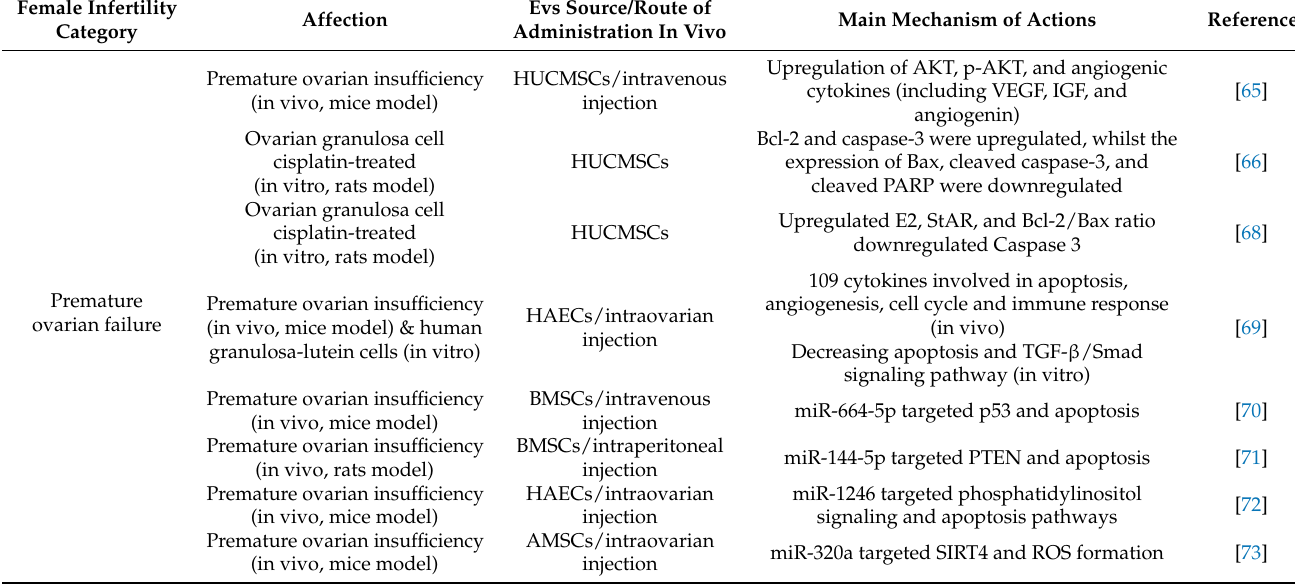
Table 1. Uses of stem cell-derived extracellular vesicles for treating female